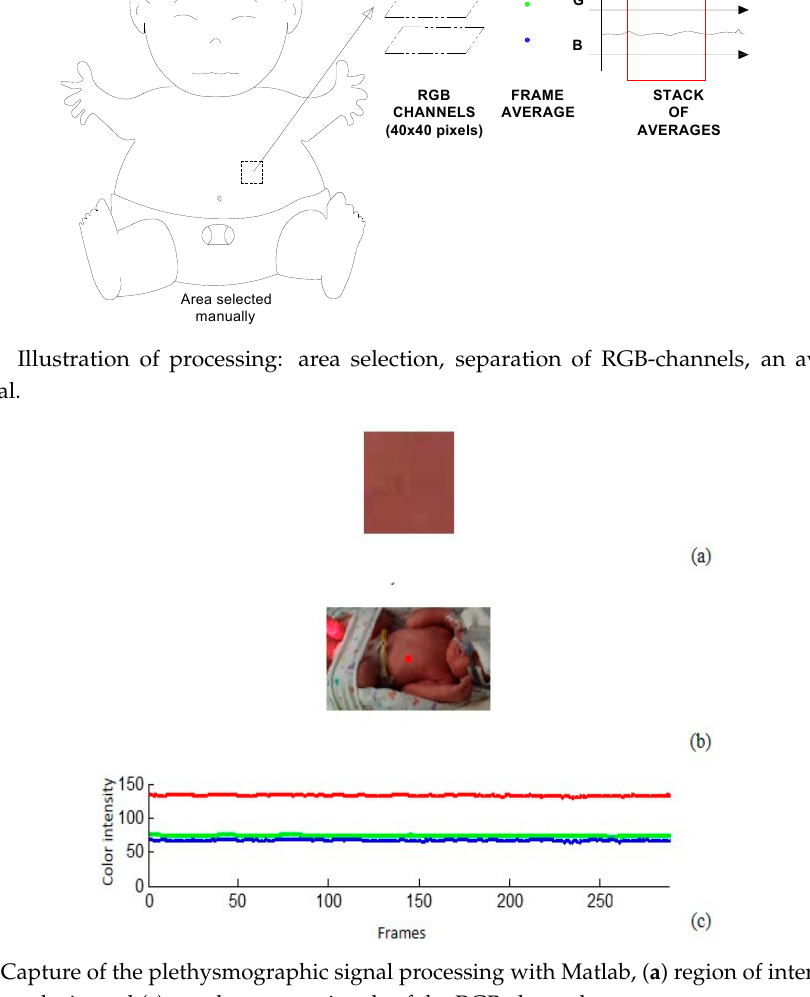
Figure 3. Illustration of processing: area selection, separation of RGB-channels, an average of each signal.